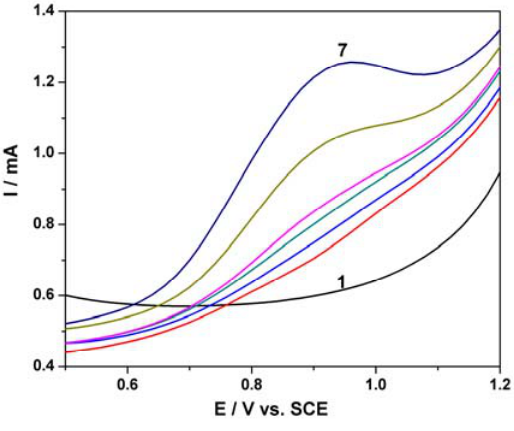
Figure 9. SWVs recorded at MWCNT-EP composite electrode under the optimum conditions of the preconcentration scheme, i.e ., accumulation time of 40 minutes with modulation amplitude of 0.1 V, step potential of 0.01 V, and frequency of 10 Hz; potential range between +0.5 V and +1.2 V/SCE in 0.1 M Na the presence of different PCP concentrations: (2) 0.2 µM; (3) 0.4 µM; (4) 0.6 µM; (5) 0.8